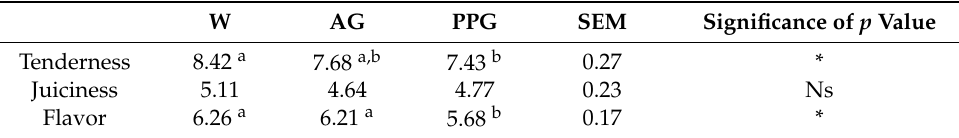
Table 7. Sensory attributes of lambs fattening on different production systems. W AG PPG SEM Significance of p